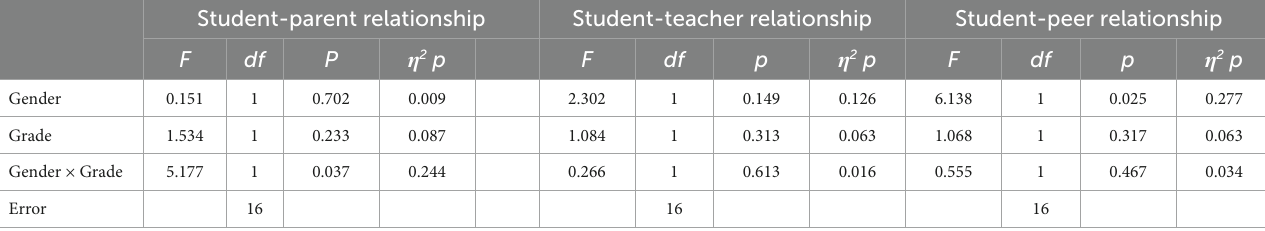
TABLE 10 ANOVA for gender and grade in relation to personal relationships and